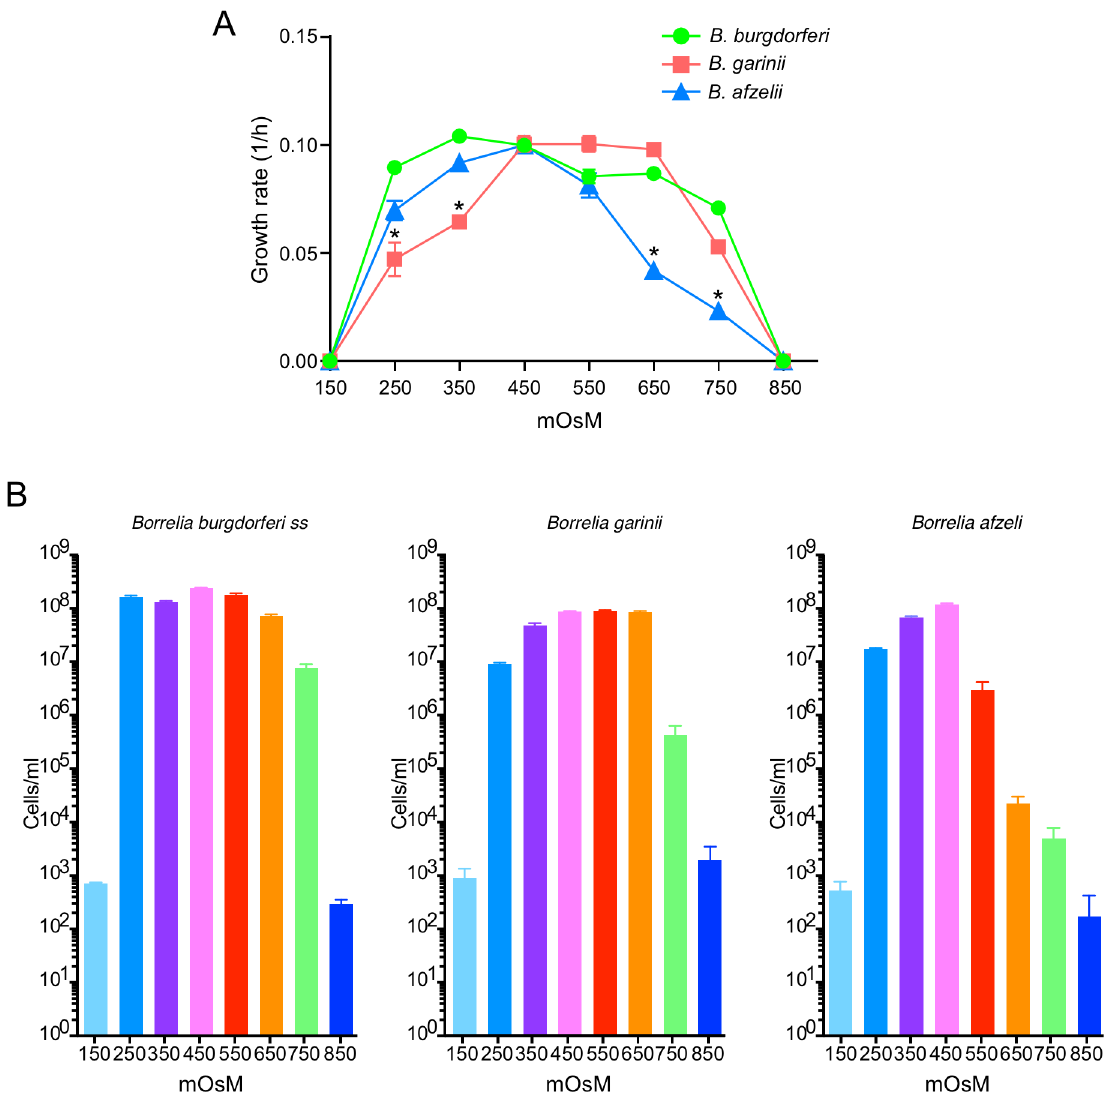
Fig 4. Rate of growth of B . burgdorferi B31-A3, B . garinii CIP 103362 and B . afzelii BO23 at various osmolarities. (A) Growth curves of strains were performed in BSK-II at various osmolarities (150 to 850 mOsM) under microaerobic conditions. (B) Graph of final densities of strains at various osmolarities. Growth was monitored daily by plating on BSK-II. Asterisks indicate a significant difference compared to B . burgdorfe ri B31 using a one-way ANOVA where p < 0.05. Data represent means ± standard deviation.